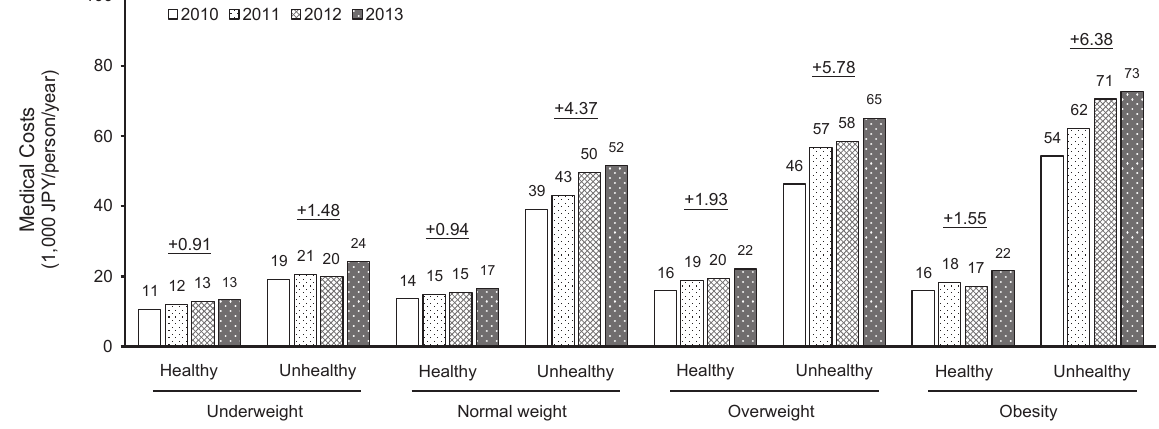
Figure 1. Median medical costs in each year and annual rise during 4 years based on BMI levels and metabolic health status Note . Cost unit is expressed as 1,000JPY (1,000JPY = 8.8 United States dollars or 7.8 euros, according to foreign exchange rates on Dec 6,